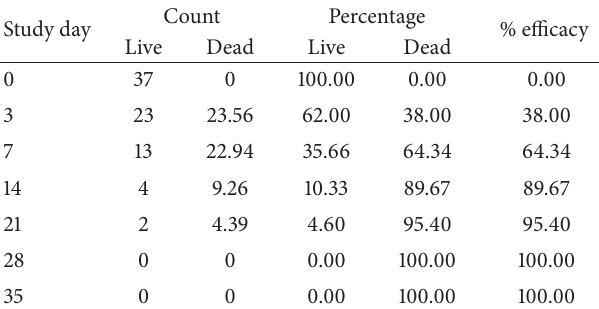
Table 2: Efficacy and speed of kill of Fiprofort Plus spot-on against fleas during 35 days of the